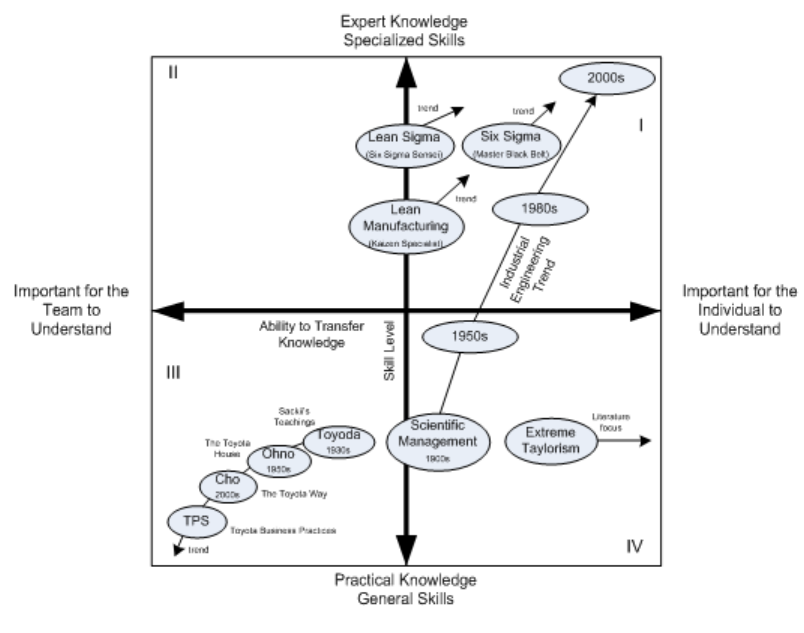
Figure 1. Representation of skills and business strategy influences for the IE